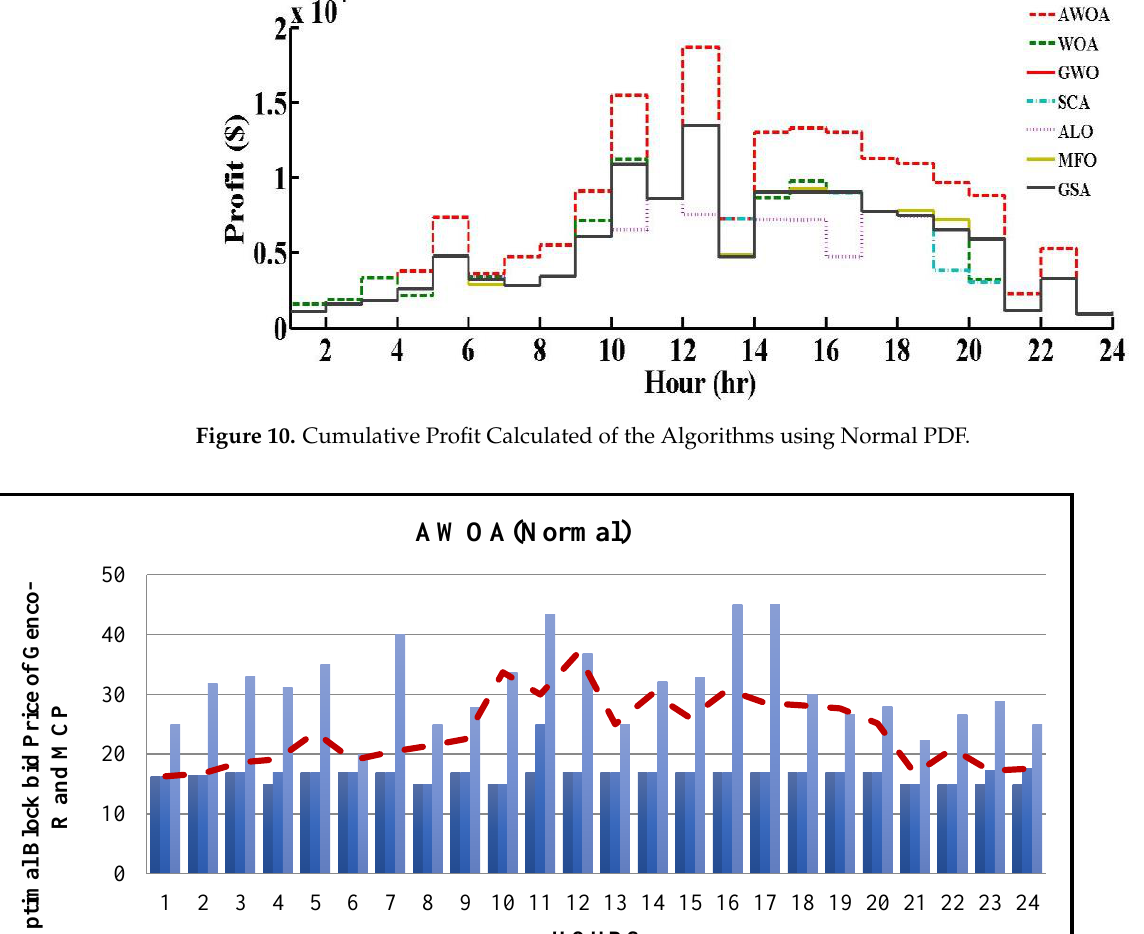
Figure 11. AWOA (Normal Distribution) Block Bid Price and MCP.